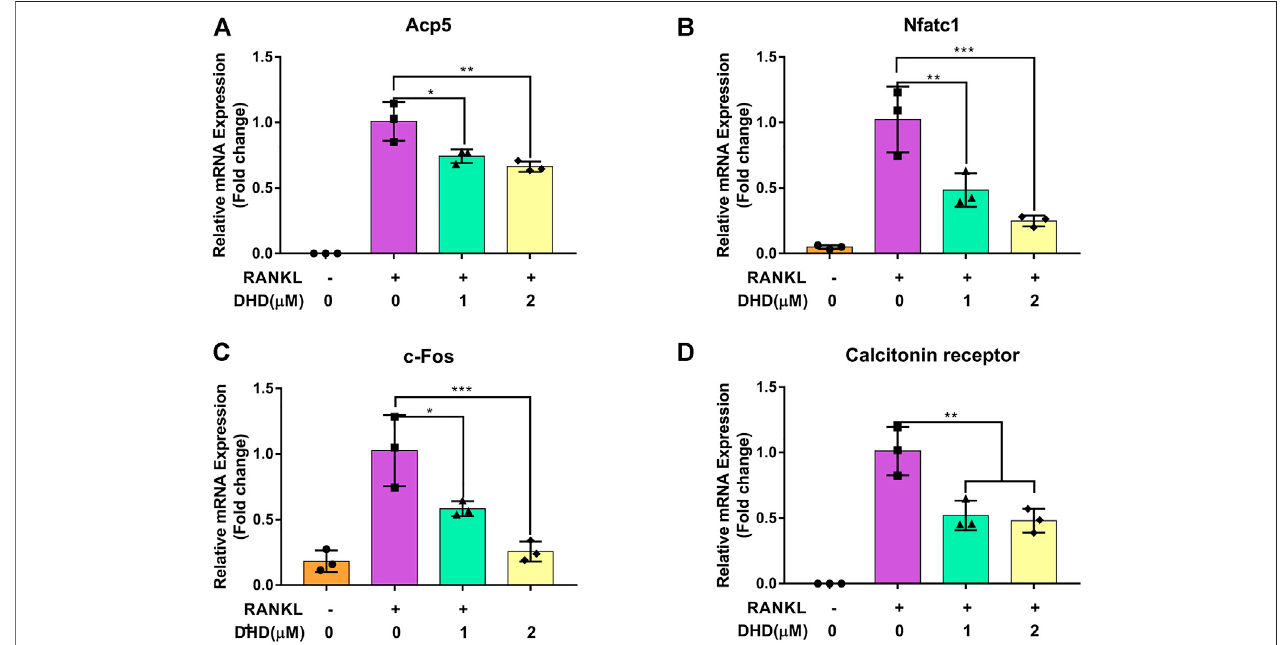
FIGURE 5 | DHD blocks osteoclasts-speci fi c gene expression. (A) Acp5, (B) NFATc1, (C) c-Fos, and (D) Ctr.